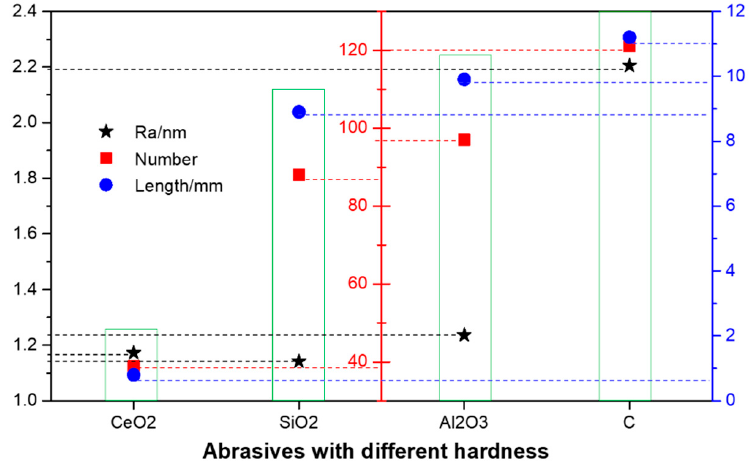
Figure 12. Statistical results of component surface scratch and average roughness after abrasive machining with different hardness.